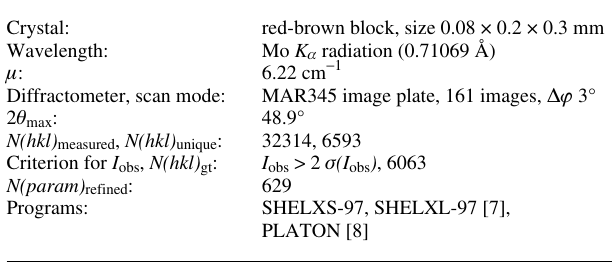
Table 1. Data collection and handling.